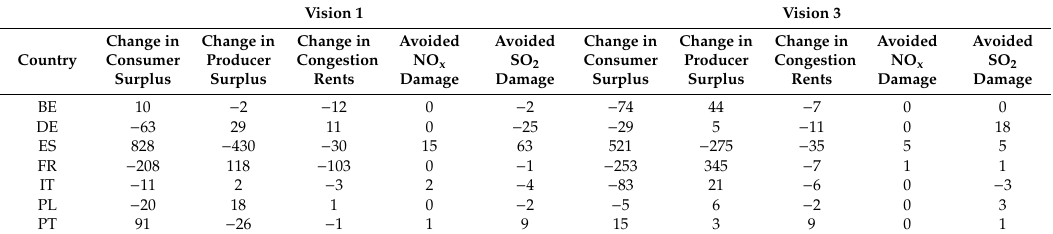
Table 6. The breakdown of the ALPD and the change in EMS to their components for the selected countries for Vision 1 and Vision 3 in